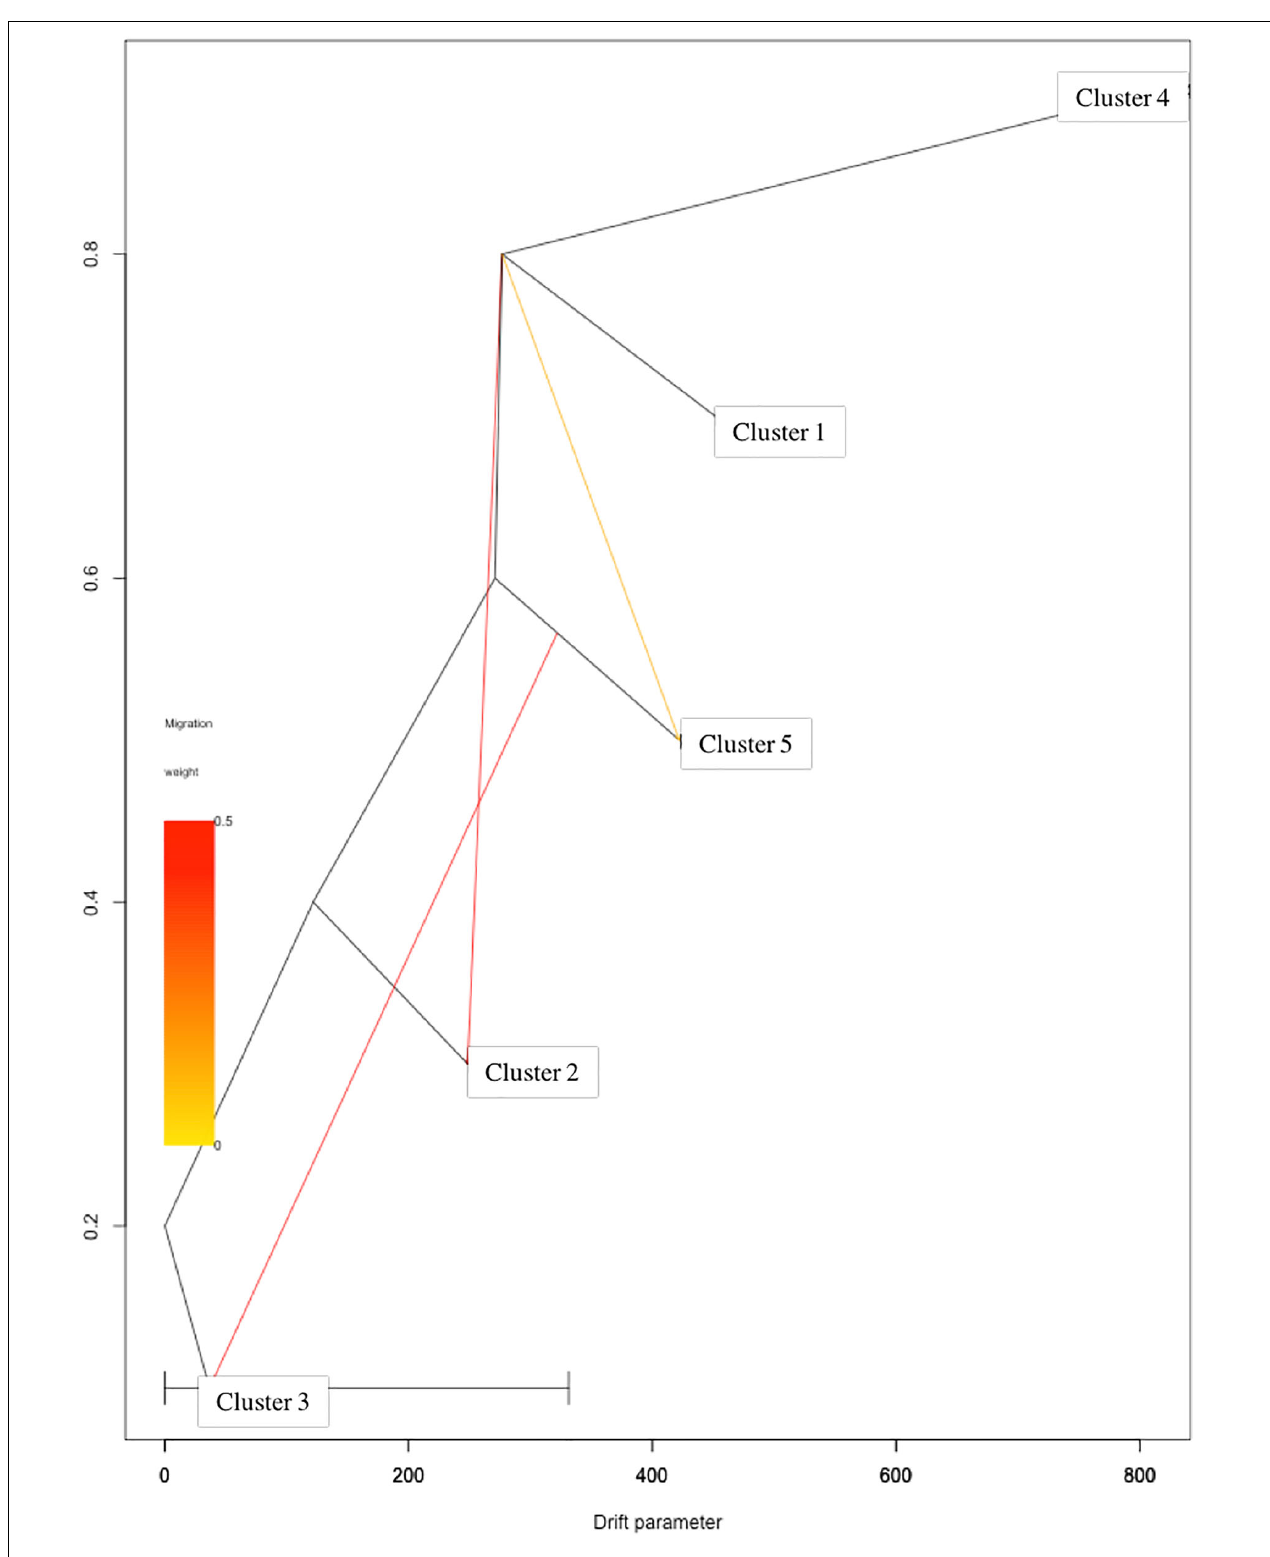
FIGURE 4 | TreeMix analysis with three migration events. Clusters in the graph corresponded to the five genetic clusters identified by STRUCTURE analysis.